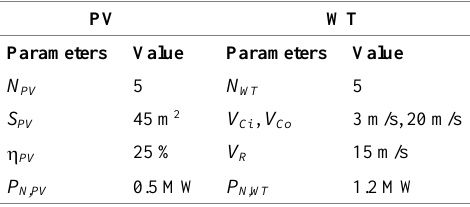
Fig. 4. Forecast of wind speed and solar irradiance in day ahead. T ABLE 1. WT S AND PV S D